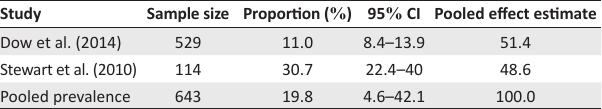
TABLE 4: Pooled prevalence of antenatal depression in Malawi. TABLE 5: Pooled prevalence of postnatal depression in Malawi.